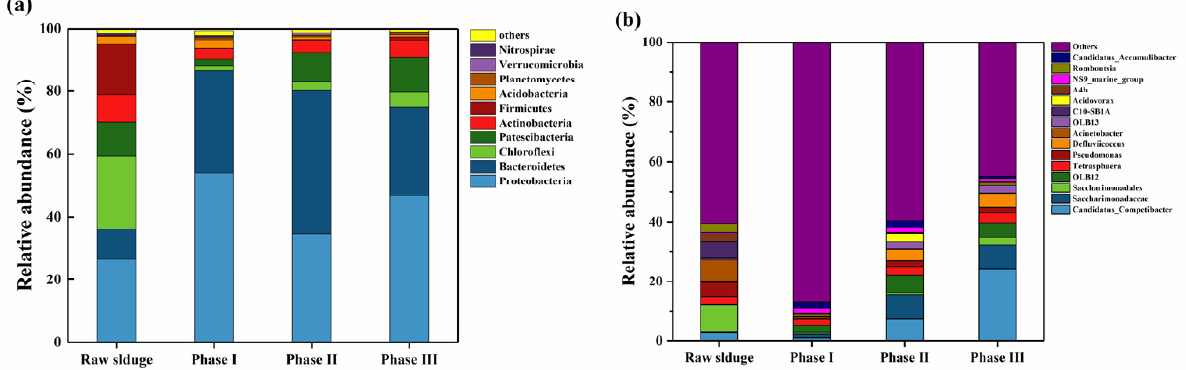
Figure 3. Relative abundances of microbial community composition at the ( a ) phylum and ( b ) genus levels during the experiment.